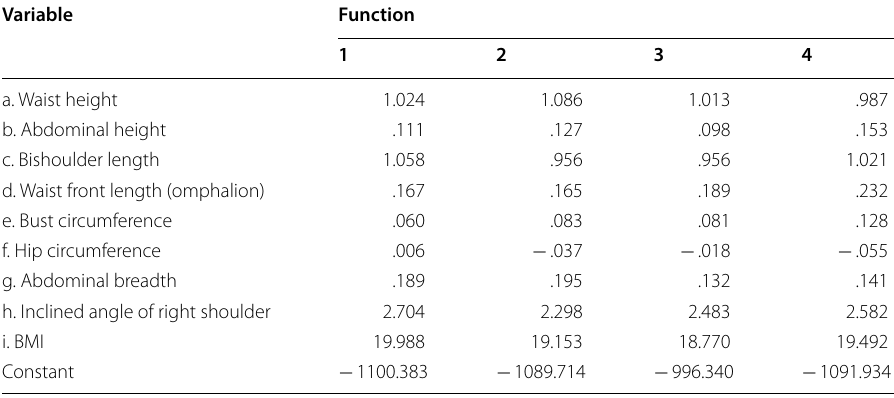
Table 12 Classification function coefficients of Fisher’s linear discriminant